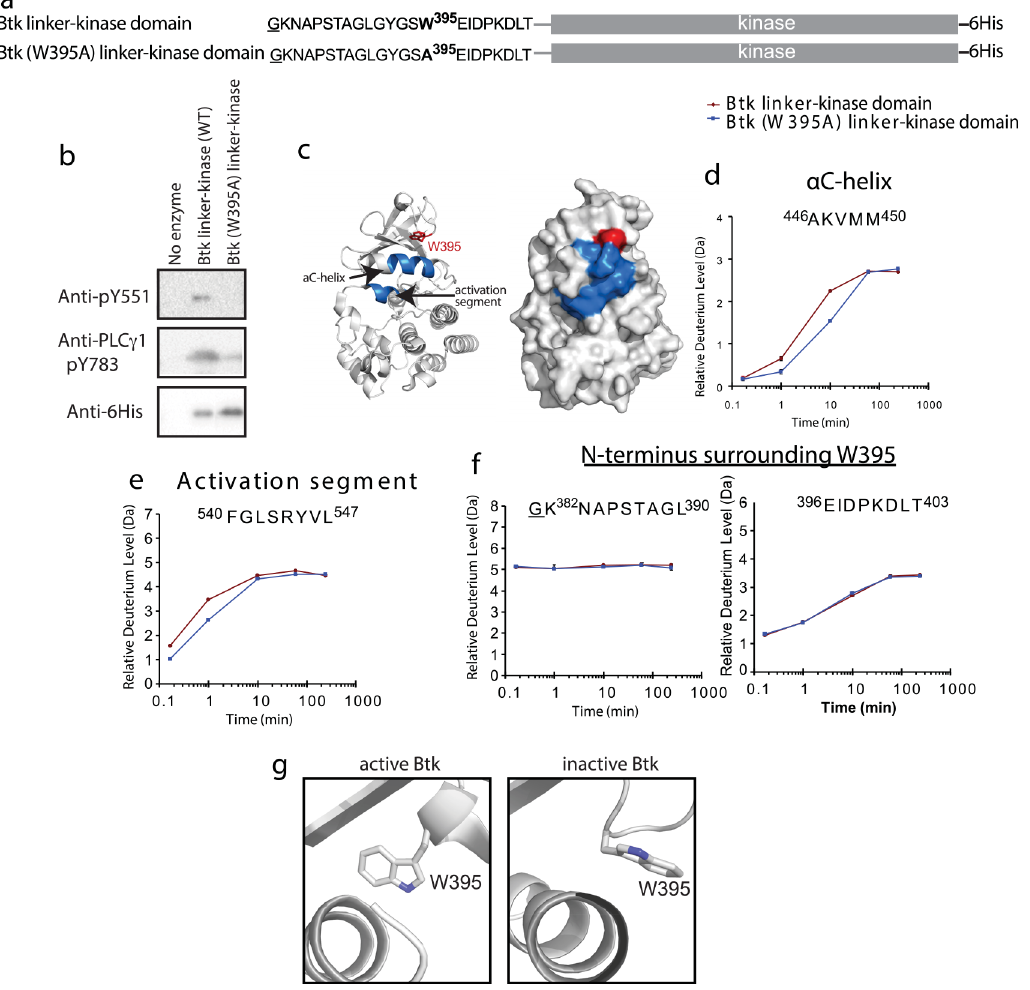
Fig 2. HDXMS reveals greater conformational sampling for active Btk linker-kinase domain. (a) Constructs used for activity assays and HDXMS study. The underlined residue is vector derived and not part of the sequence of the Btk kinase domain. Both Btk linker-kinase and Btk (W395A) linker-kinase carried a hexahistidine tag (6His) at the C-terminus. (b) Western blot assay to probe phosphorylation of the Btk activation loop Y551 and Y783 in the PLC γ 1 substrate. Anti-His antibody recognizes the 6-His tag on the Btk constructs and is used to detect the amount of Btk enzyme in each reaction. (c) Differences greater than 0.7 Da at any one of the five time points between 10 seconds and 4 hours in the hydrogen-deuterium exchange experiment are mapped onto two depictions of the Btk linker-kinase domain (PDB ID: 3GEN) and colored in blue. The side chain of W395 is red and labeled. (d-e) Deuterium exchange for peptides derived from the α C-helix and activation segment in Btk linker-kinase (red) and Btk (W395A) linker-kinase (blue). (f) Deuterium exchange for peptides derived from the linker and N-terminal region of Btk linker-kinase (red) and Btk (W395A) linker-kinase (blue). Complete HDX data is provided in Fig A in S1 Text. (g) Side-chain rotamer conformations of W395 in the structures of active (3K54) and inactive (3GEN) Btk